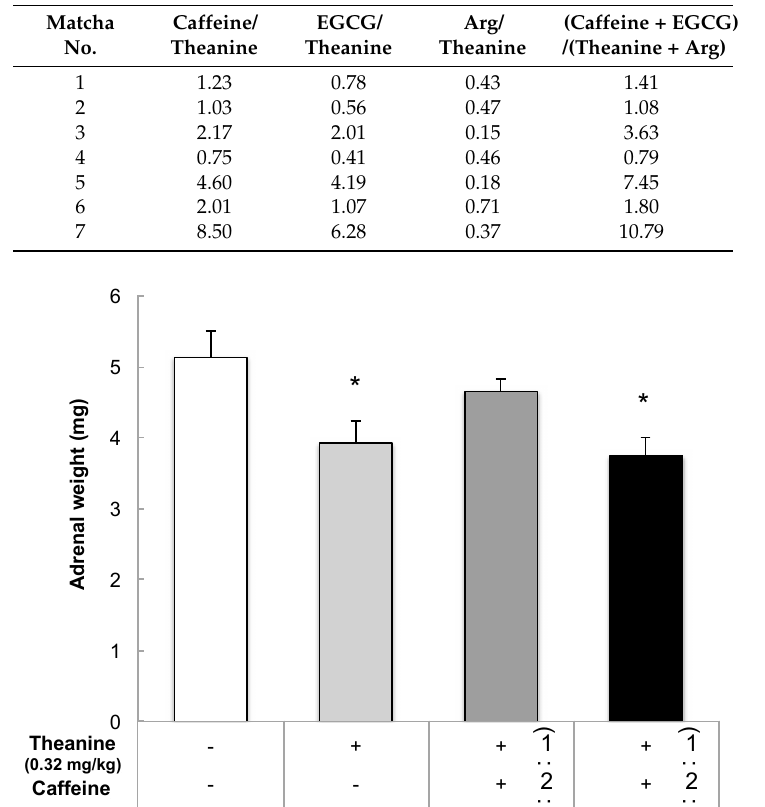
Table 4. Molar ratios in matcha samples.